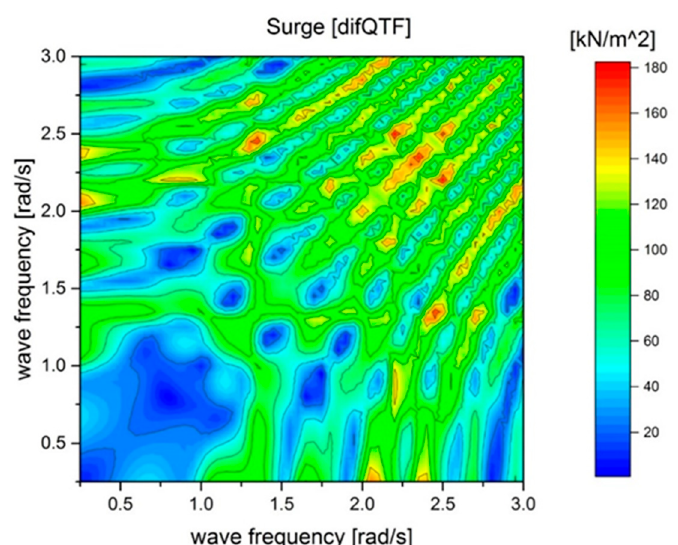
ff erence-frequency QTF for Figure 4. Amplitude of difference-frequency QTF for surge. Figure 4. Amplitude of di